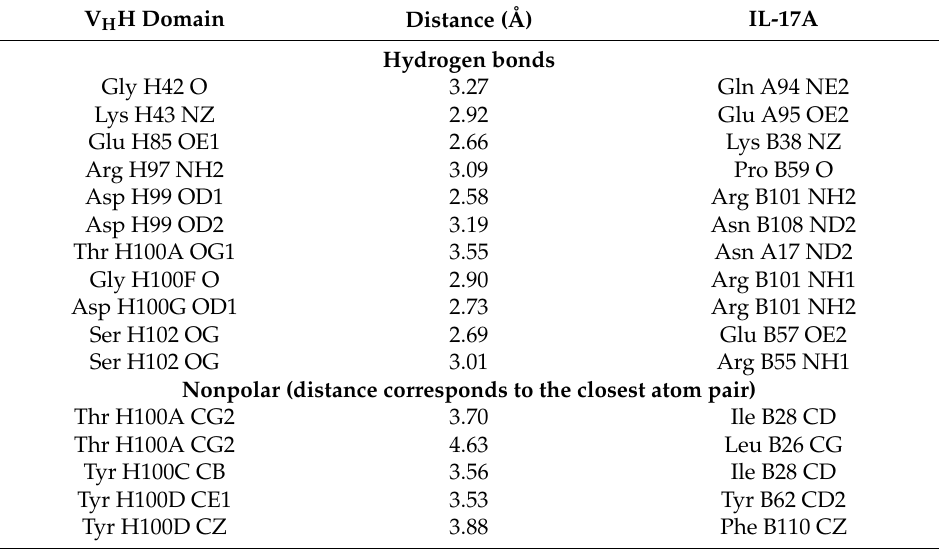
Nonpolar (distance corresponds to the closest atom pair) Thr H100A